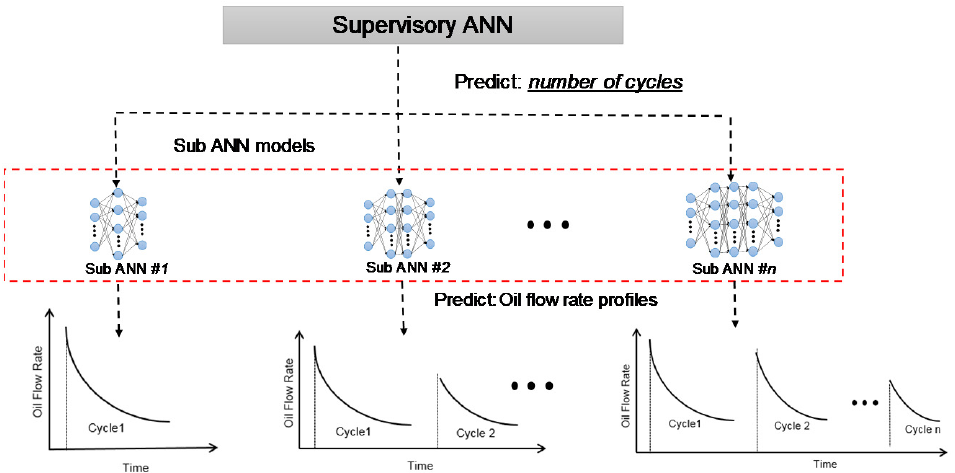
Figure 8. Division of work between the supervisory ANN and sub-ANN models of the CSS process [7]. The supervisory ANN is a fully connected three-layer model with its 78, 83, and 68 neurons on the first, second, and third intermediate layers, respectively. On the input layer with the help of 30 neurons, input parameters involving spatial properties, initial conditions, fluid properties, relative permeability coefficients, and project design param- eters including steam quality, steam injection rate, steam temperature, production well bottom hole pressure, well drainage radius, injection duration, soaking duration, and cycle switching rate are provided to the network. As explained above, the output layer with one neuron, simply predicts the number of cycles. Once the number of cycles is learned from the supervisory ANN, the corresponding sub-ANN developed for that specific number of cycles predicts the oil production rate as shown in Figure